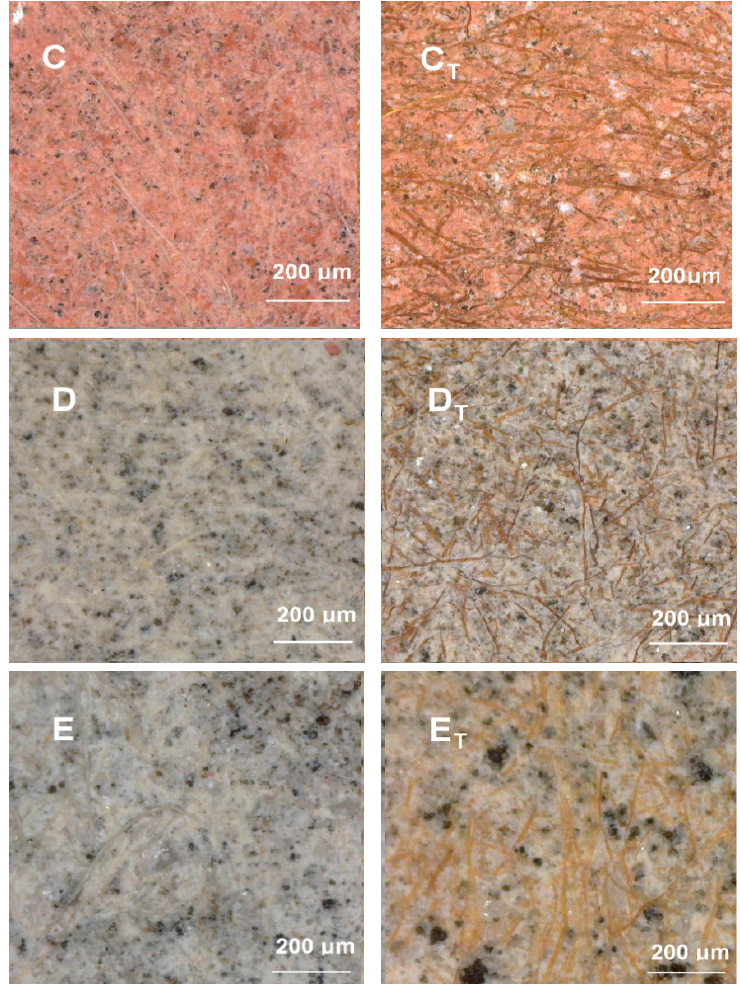
Figure 4. Micrographs of the surface views of the investigated specimens. Left : before the elevated temperature treatment; Right : after the elevated temperature treatment. temperature treatment; Right : after the elevated temperature